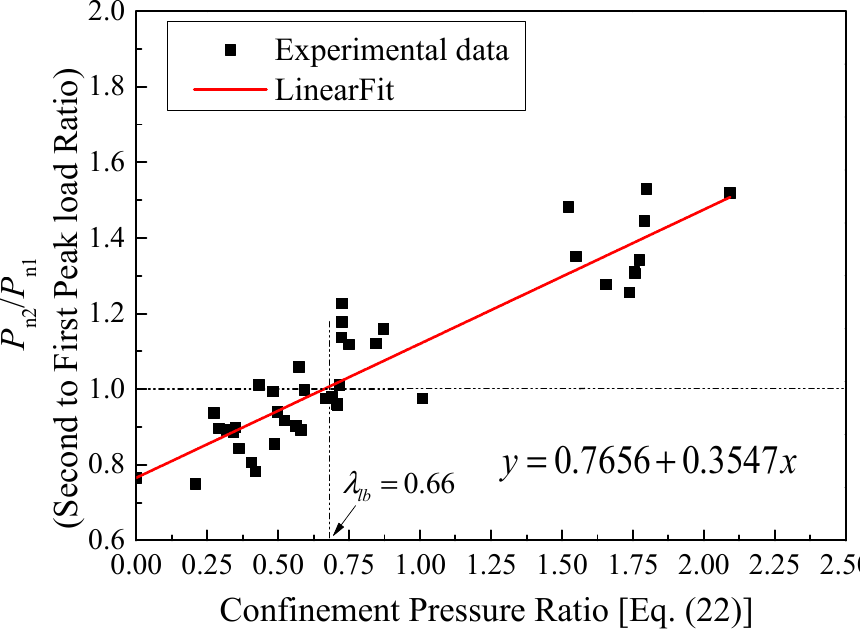
Figure 27. Relationship between confinement pressure ratio and confined load ratio.